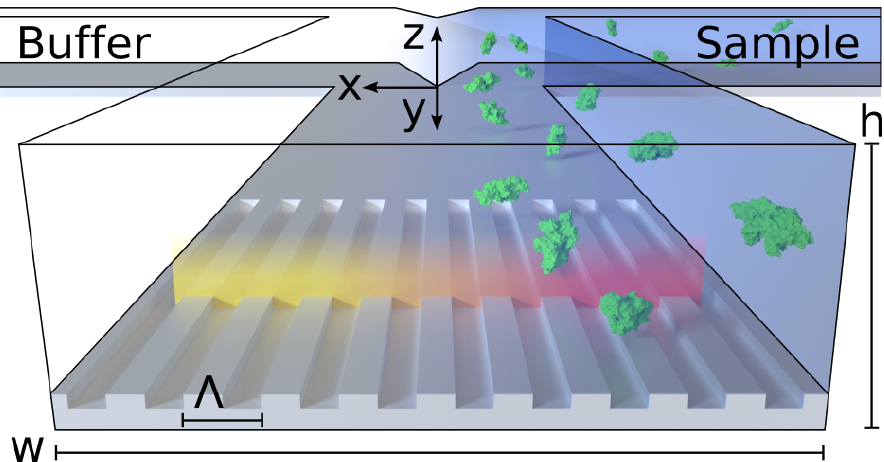
Figure 1. Schematic illustration of the sensor-embedded microfluidic H-filter operating principle. Two liquid streams meet and co-flow laminarly in a channel of height h and width w . The embedded sensor has a grating period of Λ and measures along a line. The color of light reflected by the sensor redshifts as molecules diffuse along x . Small molecules, shown in blue, will diffuse further and thus have a softer transition profile than larger molecules, exemplified by bovine serum albumin (BSA) in green (crystal structure 4F5S) [22]. The embedded label-free sensor monitors the extent of diffusive mixing in